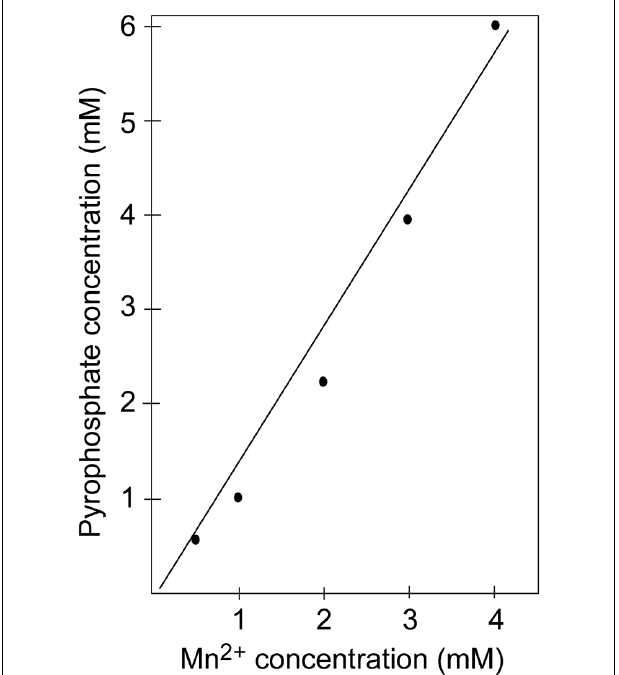
FIGURE 4 | Inhibiting pyrophosphorolysis with manganese. Increased manganese is needed to inhibit the pyrophosphorolysis reaction catalyzed by the exonuclease-deficient L412M-DNA polymerase when the concentration of PPi is